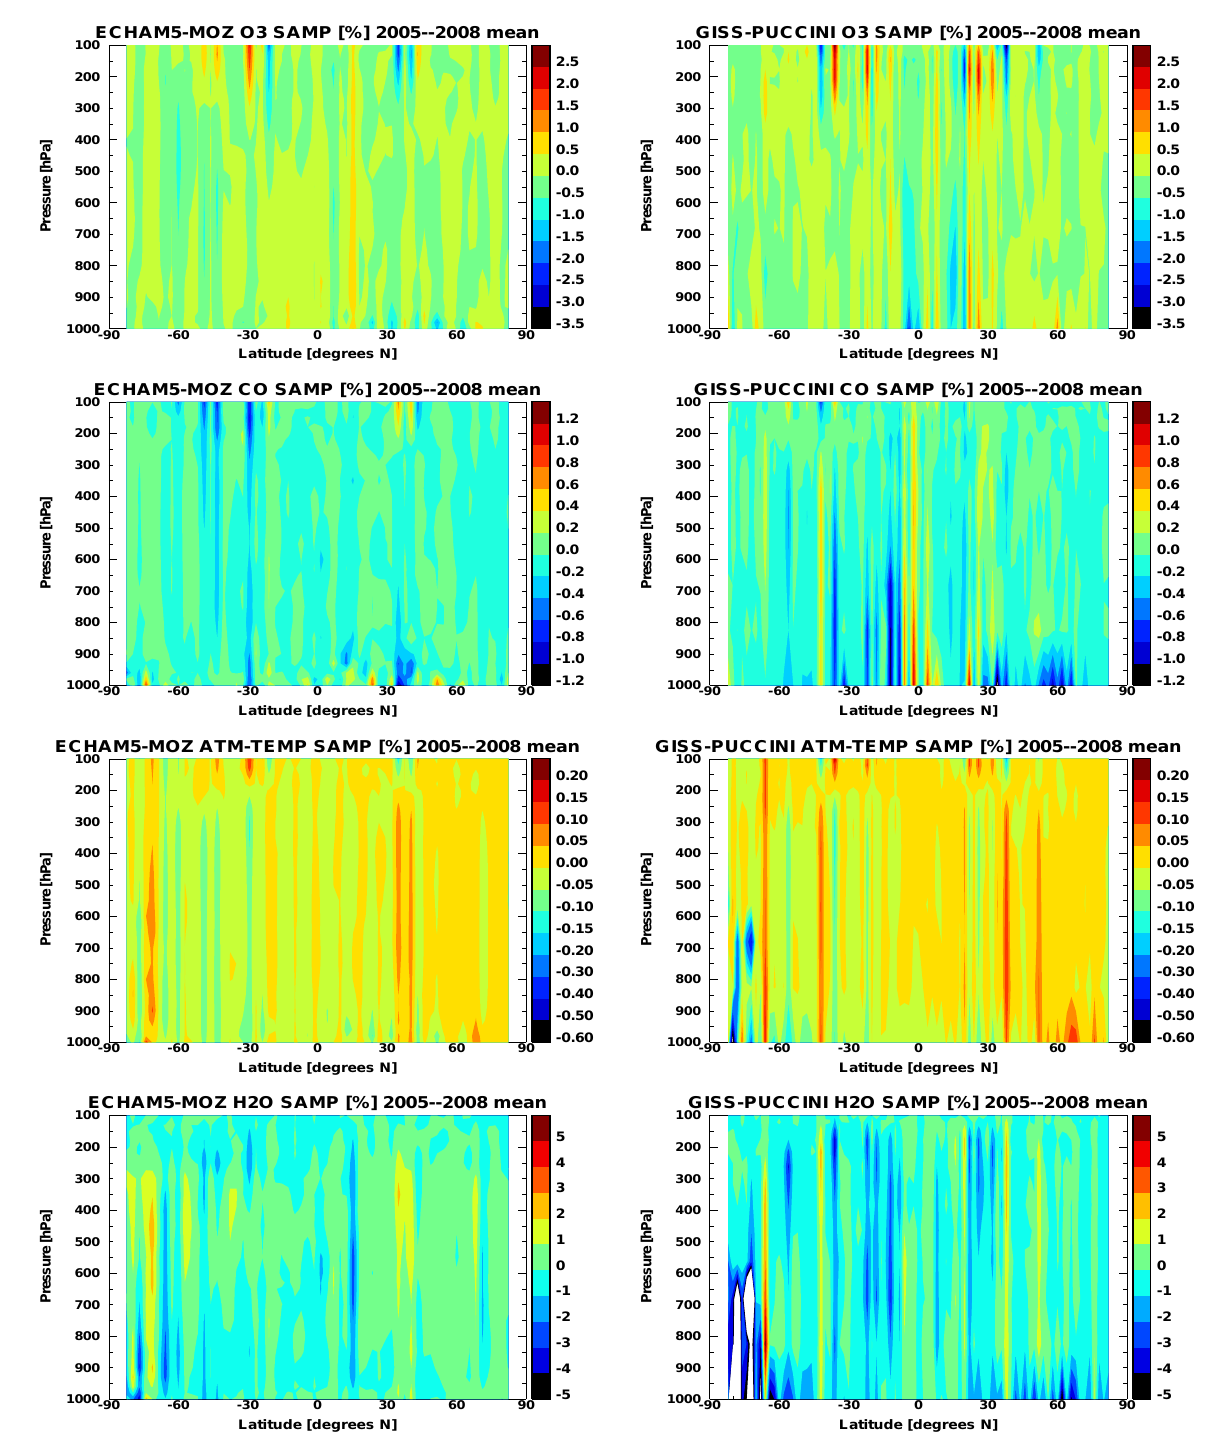
Fig. 4a. The 2005–2008 monthly-mean zonal average of the percentage error introduced by sampling in the ECHAM5-MOZ (left column) and GISS-PUCCINI (right column) models. The influence of sampling on ozone, carbon monoxide, atmospheric temperature and water vapour are shown on the first, second, third and fourth rows